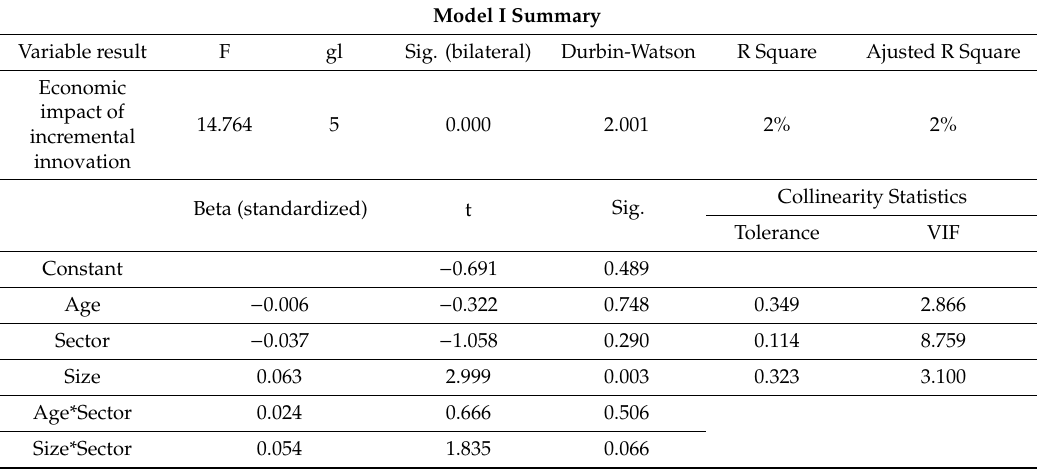
Table 3. Control variables and economic impact of incremental